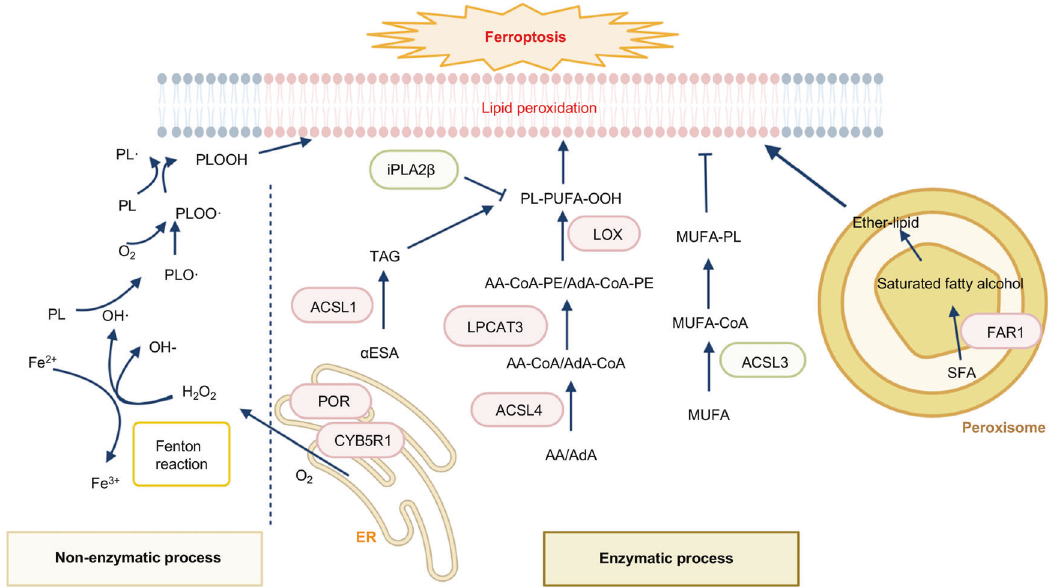
Fig. 1 The lipid peroxidation associated pathways. The non-enzymatic process (as Fenton reaction) and enzymatic process (as ACSL4, LPCAT3, LOXs, FAR1, POR) participate in ferroptosis by the production of lipid peroxidation in membrane PLs. The enzyme-induced ferroptosis is colored in a red box, while the enzyme-inhibiting ferroptosis is colored in a green